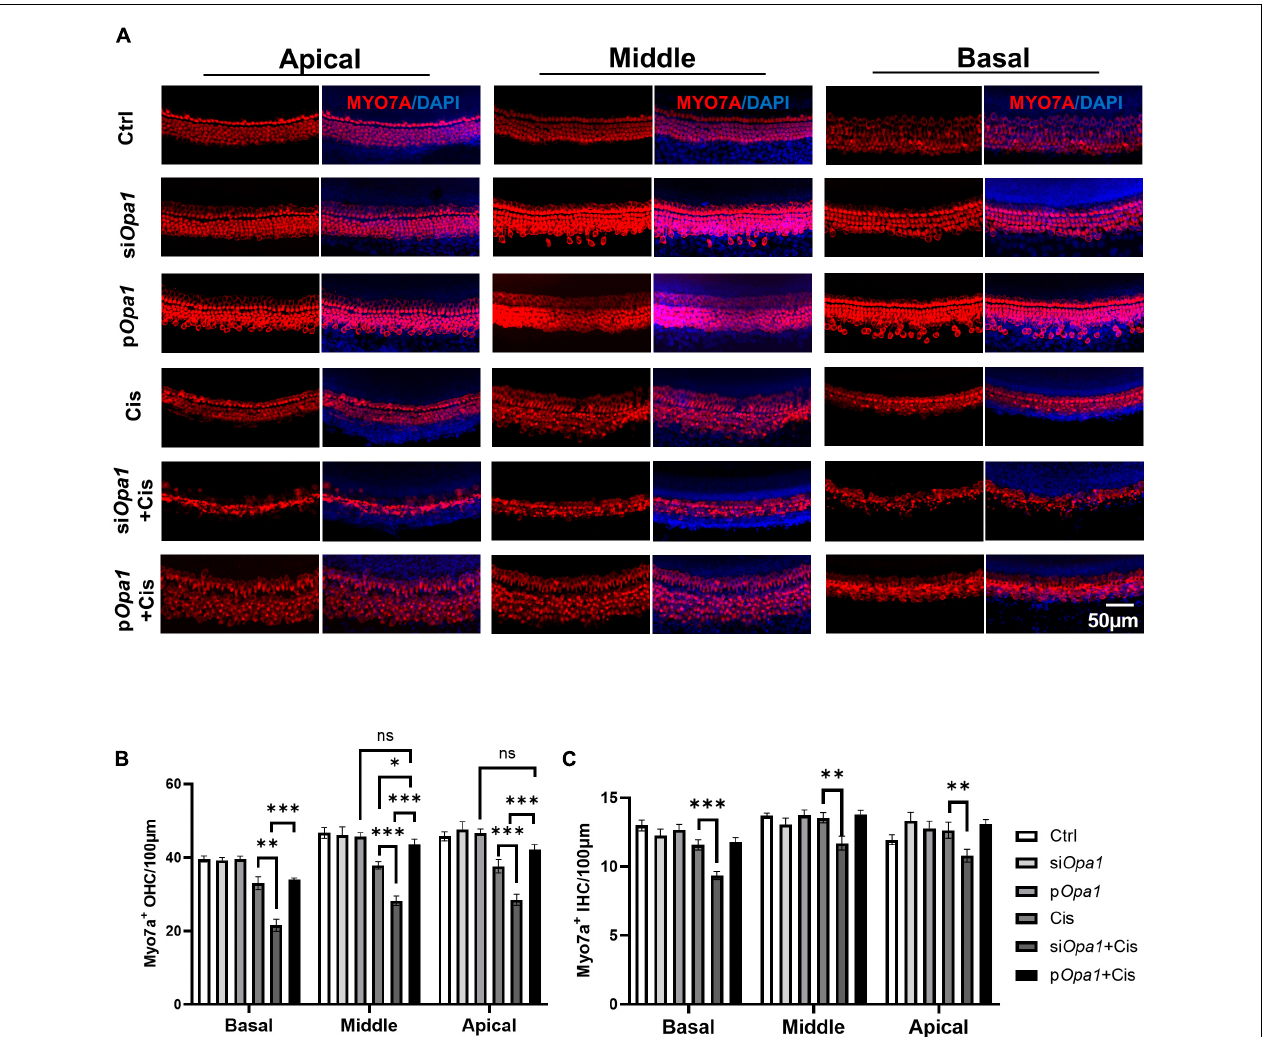
FIGURE 6 | Opa1 knockdown or overexpression respectively aggravates or partially rescues cisplatin induced hair cell damage in organotypic cochlear cultures. (A) Representative confocal images of the apical, middle, and basal regions of organotypic cochlear cultures transfected with si Opa1 or Opa1 and treated with 60 µ M cisplatin. Hair cells are indicated by MYO7A staining (red) and nuclei are indicated by DAPI staining (blue). (B,C) Quantification of IHCs (B) and OHCs (C) in the apical, middle, and basal turns. N = 3–5 per groups. ∗ p < 0.05, ∗∗ p < 0.01, ∗∗∗ p < 0.001 (two-way